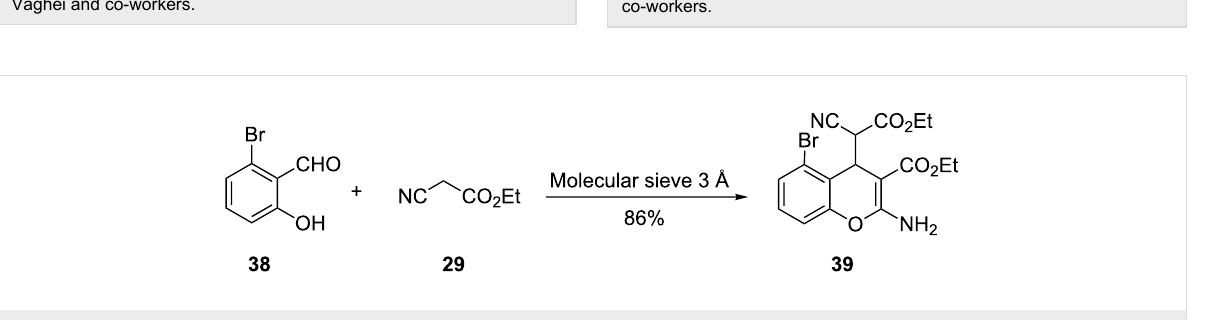
Scheme 14: Synthesis of 2-aminochromene 39 by Yu and co-workers.